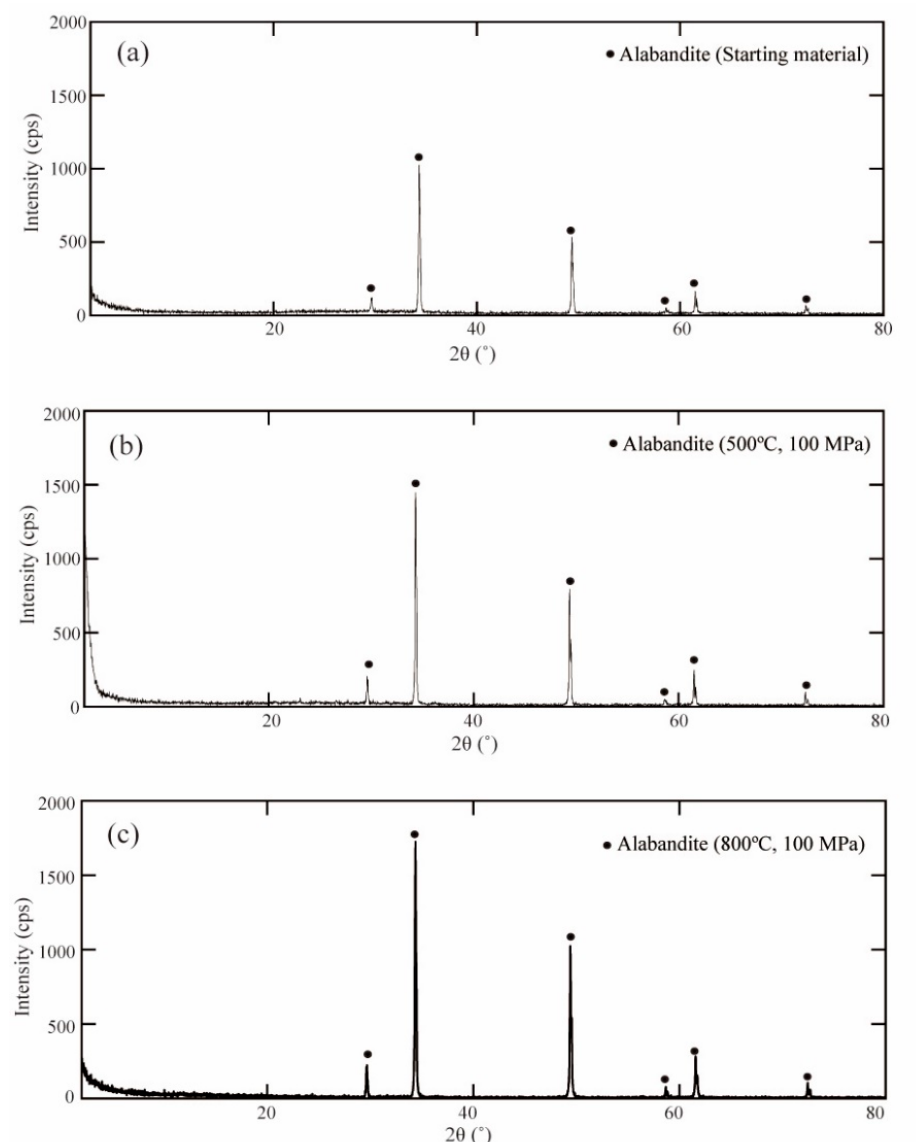
Figure 1. Powder X-ray diffraction patterns of the starting material (MnS) and synthesized minerals. ( a ) MnS, ( b ) alabandite synthesized at 500 °C and 100 MPa (run no. 510), and ( c ) alabandite synthesized at 800 °C and 100 MPa (run no. 813).